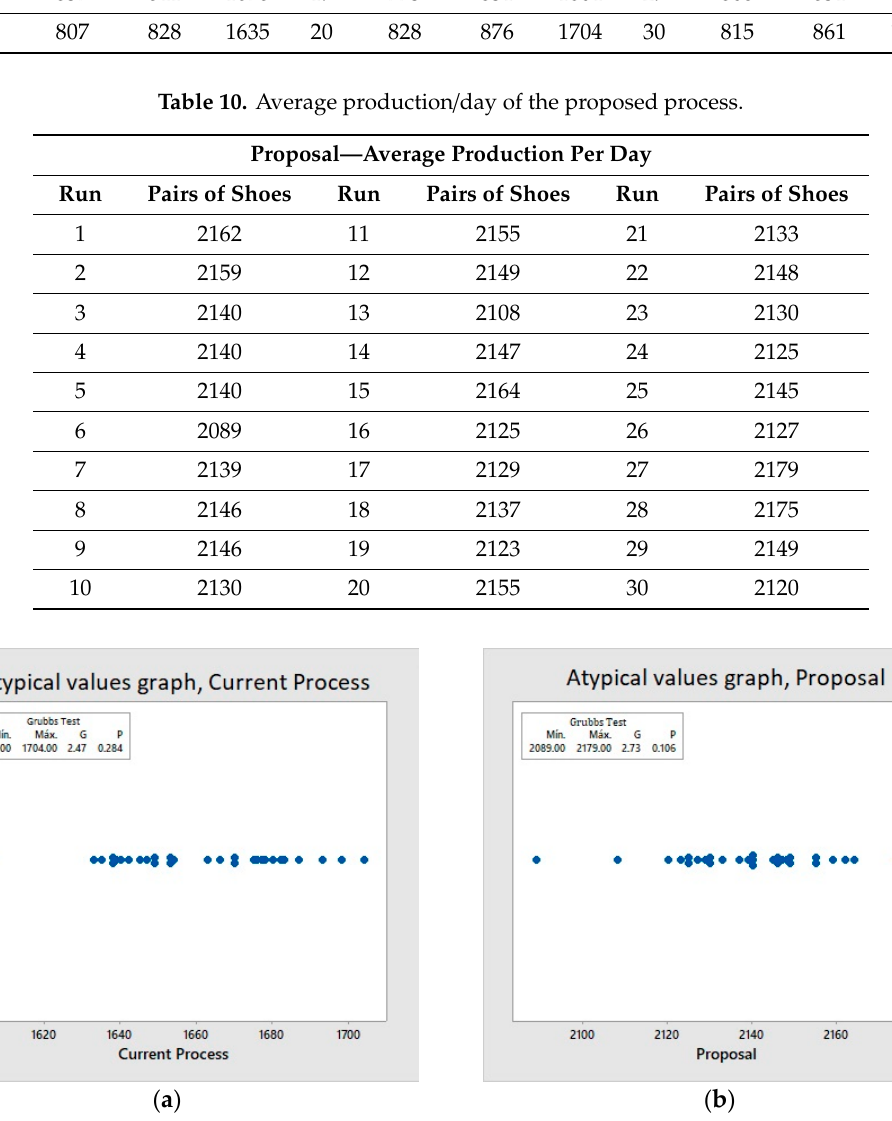
Table 10. Average production/day of the proposed process.